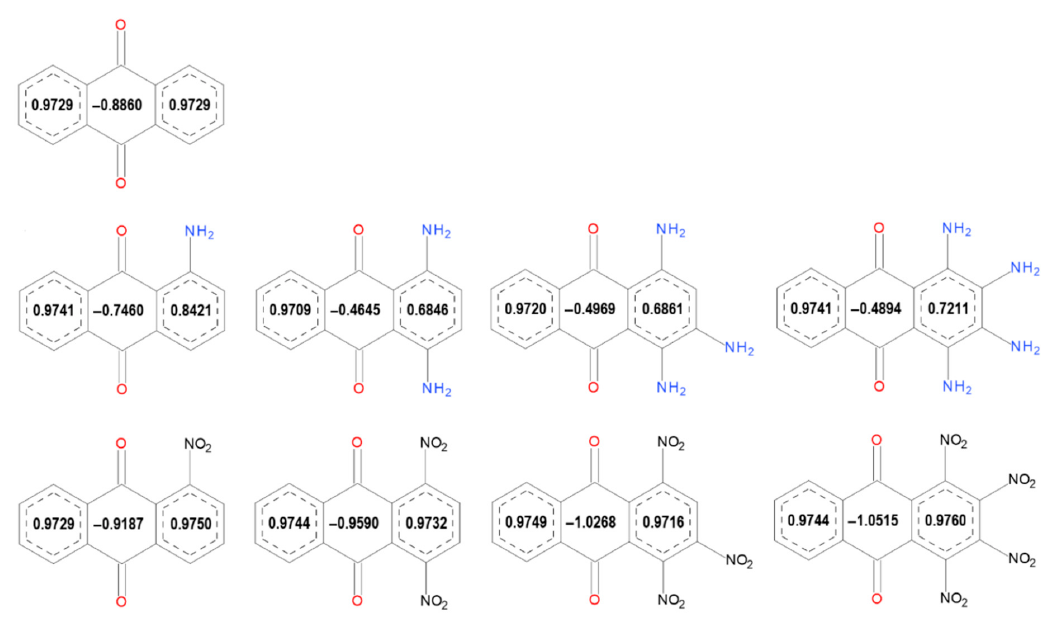
Figure 4. HOMA parameters for anthraquinone structures with a substituent in the side aromatic .